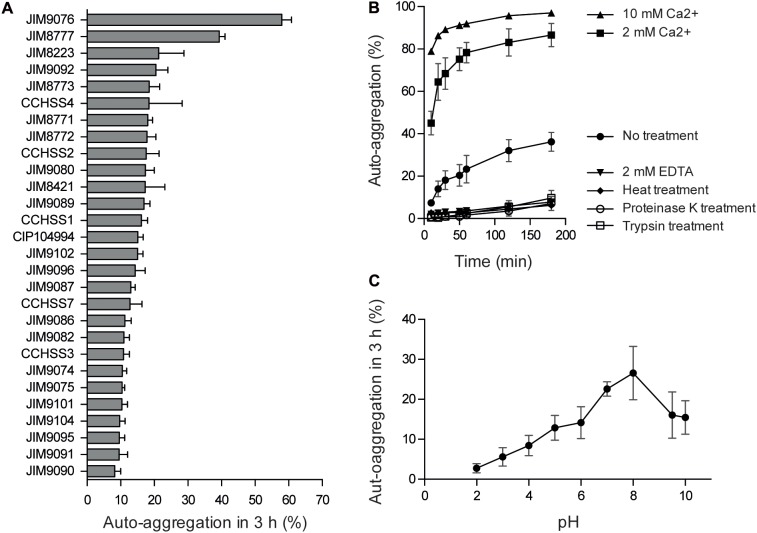
Diversity and environmental variation of the auto-aggregation phenotype in S. salivarius. (A) Auto-aggregation abilities of S. salivarius isolates. (B,C) Impact of various environmental factors on the auto-aggregation ability of S. salivarius JIM8777.